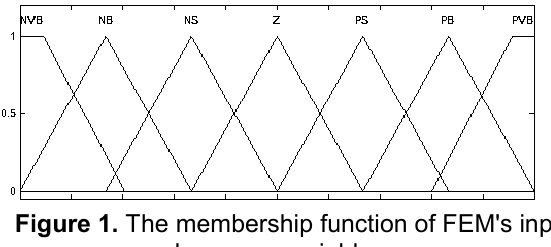
Figure 1. The membership function of FEM's input language variables